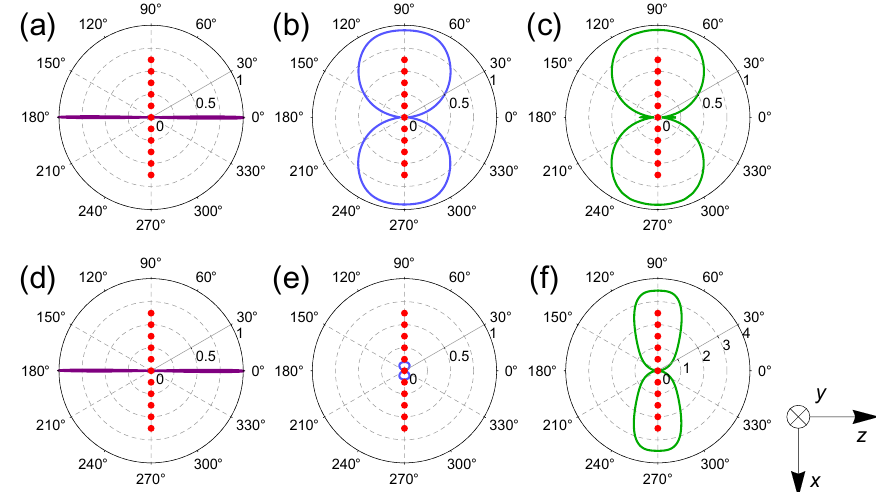
Figure 2. Classical diffraction patterns (normalised to N 2 ) and quantum additions (normalised to N ) for N fermions in a one-dimensional optical lattice (45 sites, half filling) = 10 (second row). The lattice extends in the non-interacting regime (first row) and for U/t 0 into the vertical direction, and the probe is along the horizontal, i.e. , the angle marked with 0 ◦ indicates the light intensity in the forward direction. The classical diffraction patterns ( a , d ) do not depend on the interaction while the quantum additions R ( b , e ) and R ( c , f ) y x distinguish between different ground states. Note that the scale in (f) is different from (a–e): the fluctuations in the atom number increase as the attraction between the atoms favours doubly-occupied sites. Red circles indicate the orientation of the